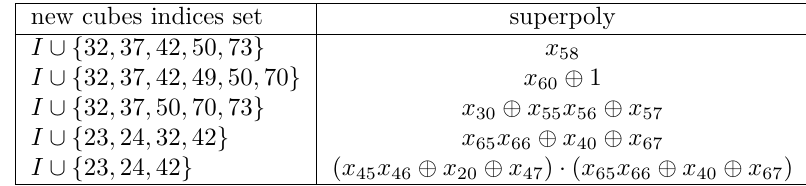
Table 2: New cubes and the corresponding